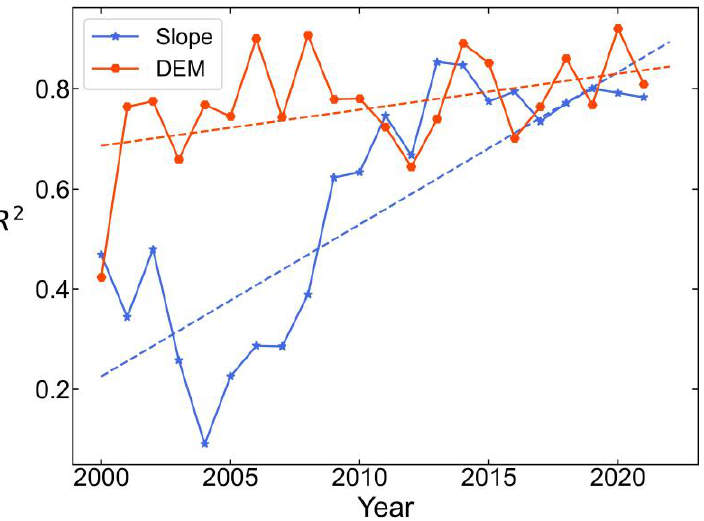
Figure 3. R 2 distribution map of the water frequency versus slope and